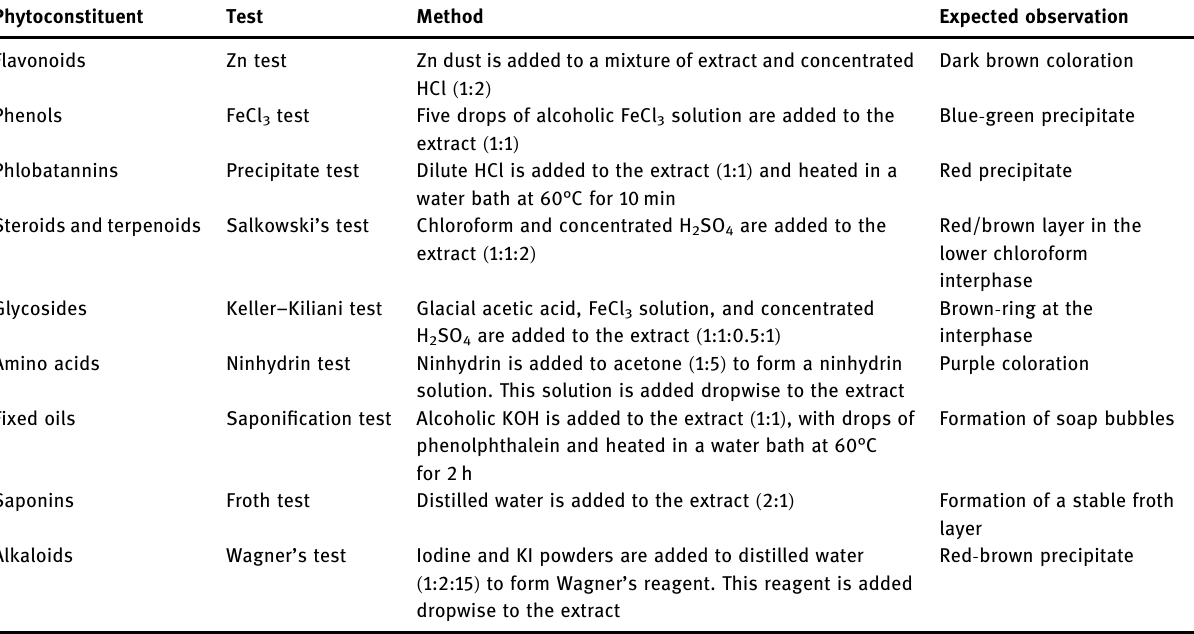
Table 1: Qualitative phytochemical screening for SMEAF